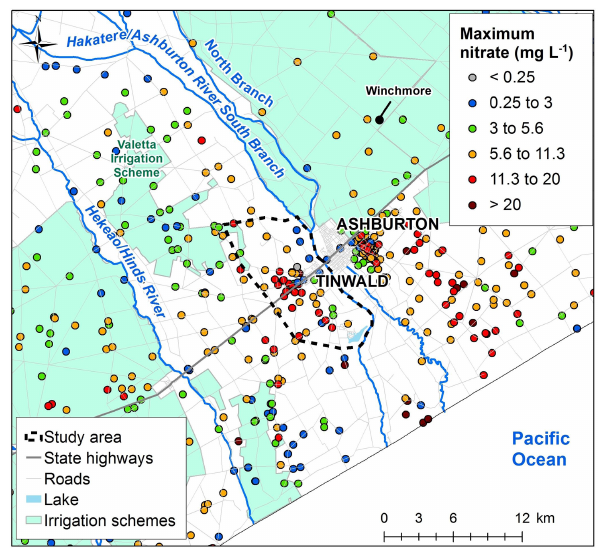
Figure 2. Maximum nitrate concentrations in the greater Ashburton area from 1990 to 2017. Base map © LINZ